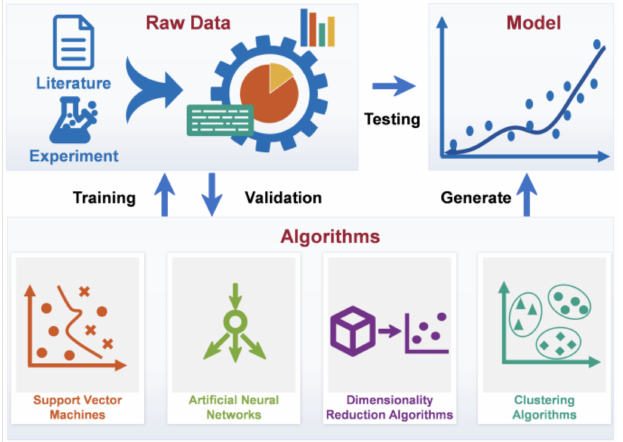
Figure 2. Data-driven modeling